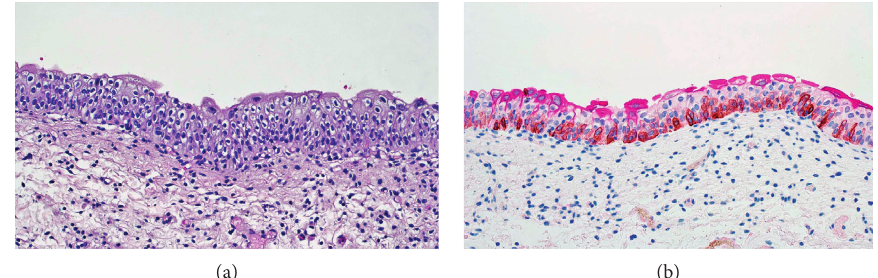
Figure 1: (a) Normal urothelium revealing multiple layers of cells including basal cell, intermediate cells, and umbrella cells. (b) Im- munohistochemical stain revealing normal staining pattern of the urothelium. The umbrella cells are decorated by CK20 (magenta). The intermediate cells are unstained. Basal cells are decorated by CK5/6 staining (brown).